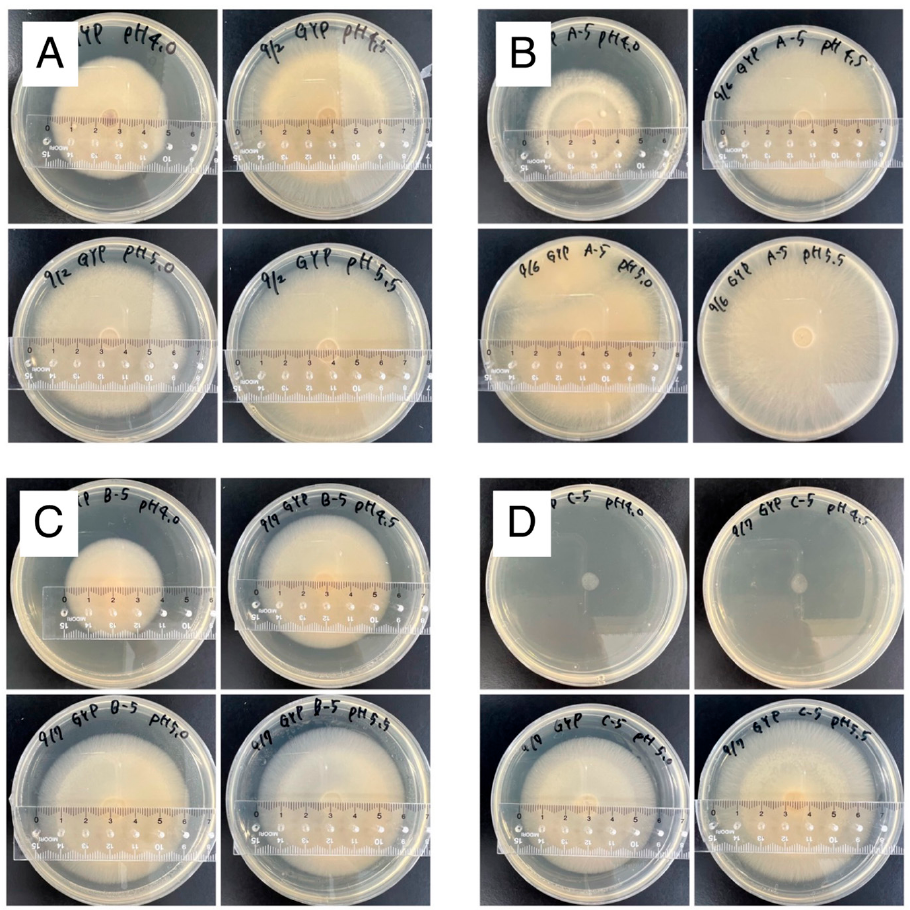
Figure 5. Effect of volatile fatty acids on the growth of Fusarium oxysporum f. sp. lycopersici at 15 °C. The GYP agar medium was adjusted at pH 5.5 (lower right), pH 5.0 (lower left), pH 4.5 (upper right) or pH 4.0 (upper left). The medium contained 5 mM each of acetate ( B ), butyrate ( C ), or caproate ( D ). Fatty acid-free controls ( A ) are also shown. Pictures were taken after incubating for 20 days.